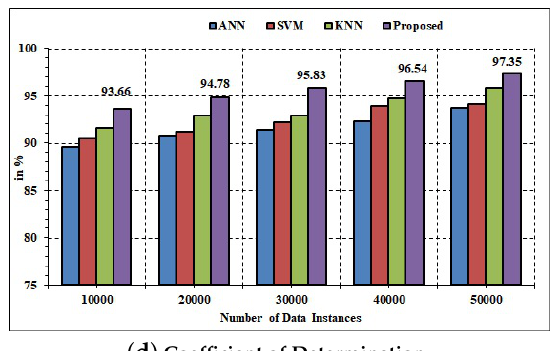
Figure 6. Prediction Efficiency.